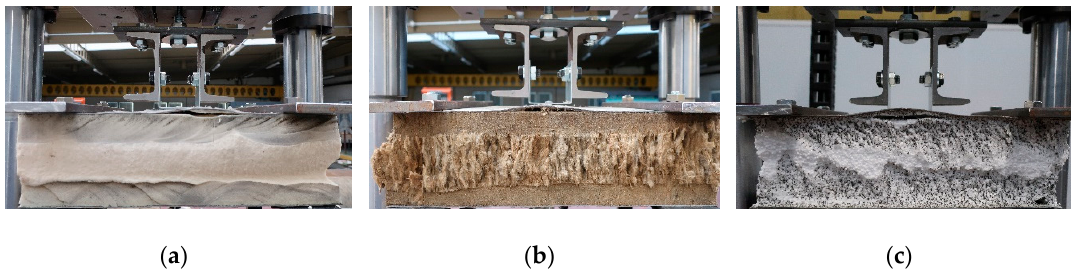
Figure 9. Failure mechanisms of the blind connection in sandwich panels: ( a ) core made of PIR foam, ( b ) core made of mineral wool, and ( c ) core made of expanded polystyrene.